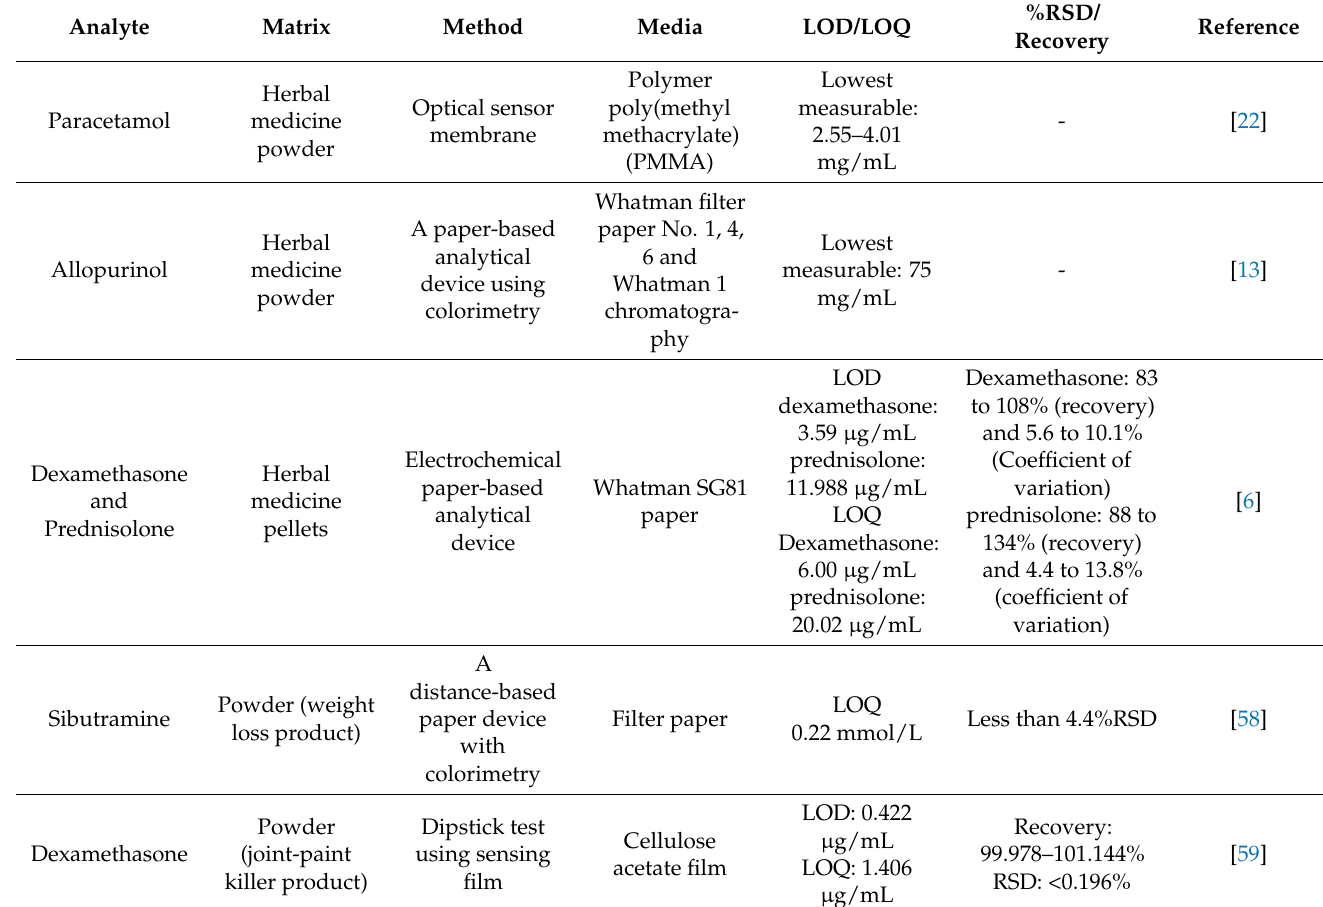
Table 3. Various analytical devices for determining adulterated drugs in herbal